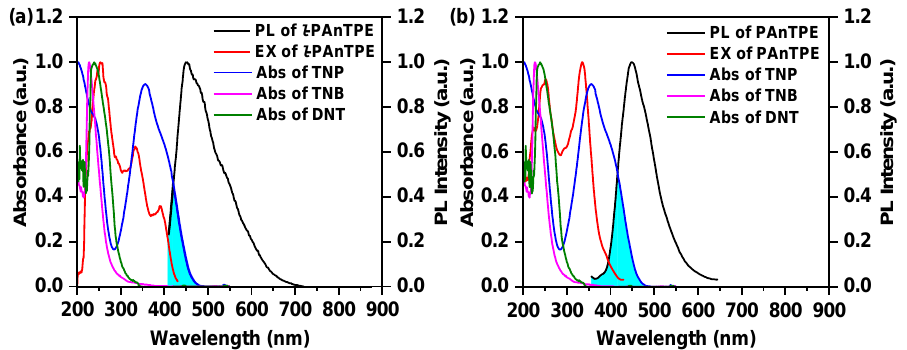
Figure 8. The excitation and PL spectra of l -PAnTPE ( a ) and PAnTPE ( b ), and the UV-Vis absorption spectra of TNP, TNB and DNT in water.